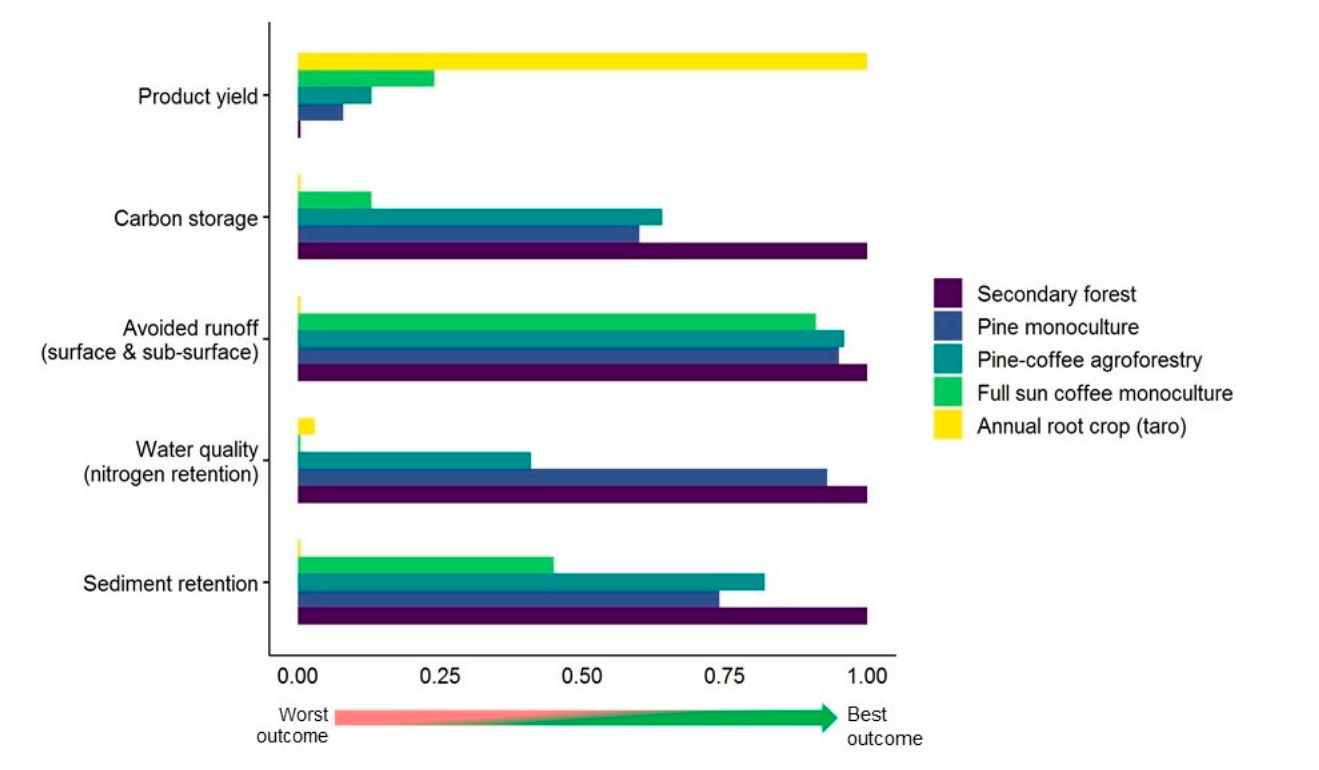
Figure 8. InVEST models of carbon storage, nitrogen retention, sediment retention and water yield were run for five different land use scenarios. Yield of crop or product was calculated separately using locally or regionally sourced data. Timber yield was not considered as a product as smallholders do not benefit from its sale. Results were normalized using minimum-maximum scaling to aid comparison between scenarios; the best performing scenario is scaled to 1 and the worst performing scenario is scaled to 0.